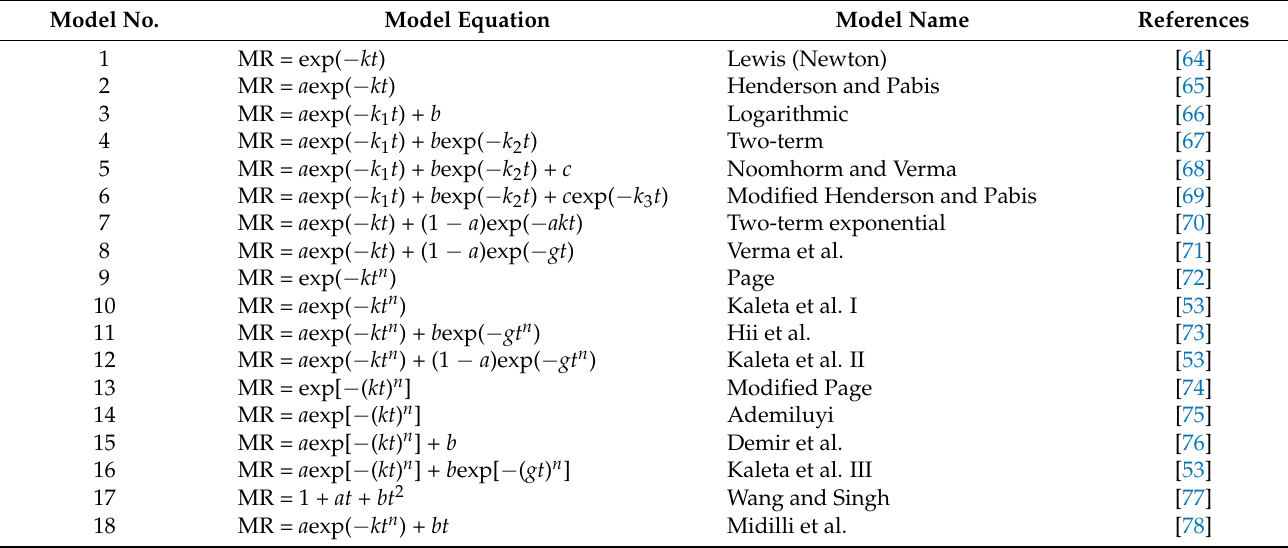
Table 1. Semi-theoretical and empirical thin-layer models applied to drying curves of sawdust. Model